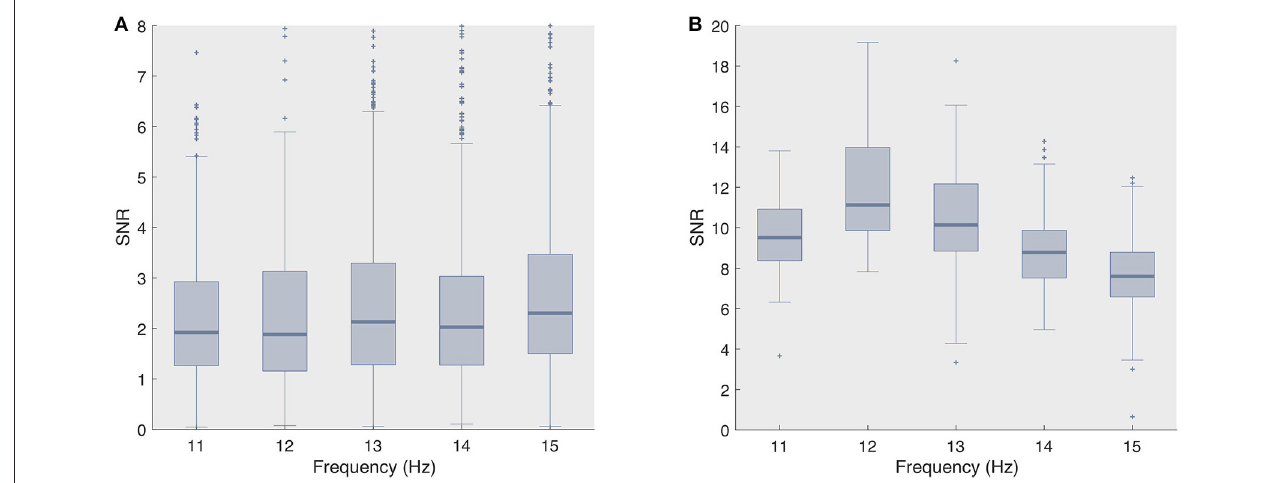
FIGURE 5 | Signal-to-noise ratio’s for all considered frequencies (A) scalp-recorded EEG and (B)